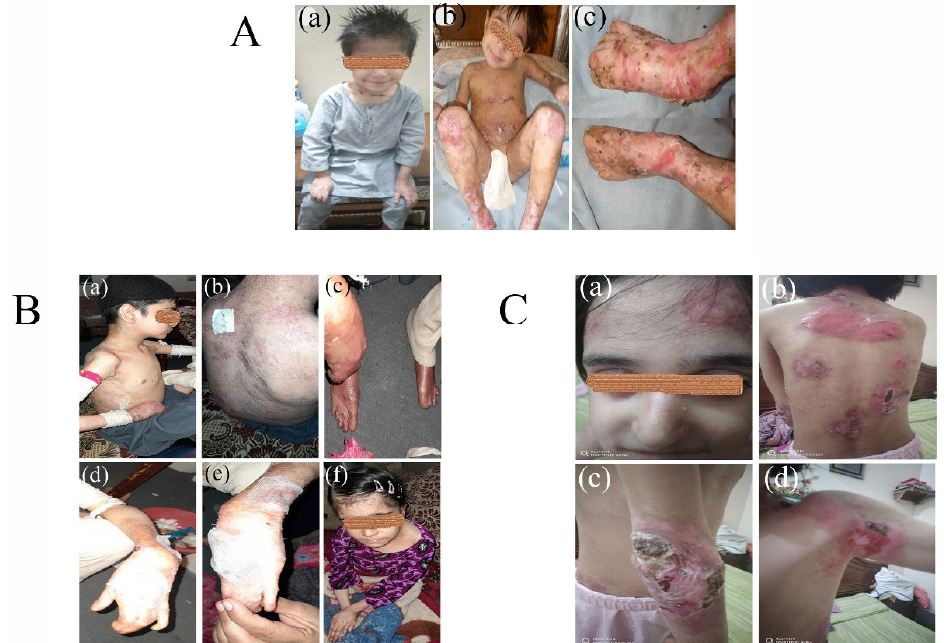
Figure 2. ( A ) Clinical phenotypes of epidermolysis Bullosa in “ Family A ”. Patient V-2 shows classical representation of Recessive Dystrophic EB, generalized severe type with abnormal blistering of the skin, erosions and atypical scarring with erythematous hyperkeratotic papule and keloids affecting his trunk, arms, hands, feet, elbows, knees and genitalia ( Aa – c ), nail dystroph, anonychia ( a ), fusion-induced mitten abnormalities of the hands and toes, joint contractures, pseudo yndactyly and growth delay ( Aa – c ). ( B ) Clinical phenotypes of epidermolysis Bullosa in “ Family B ”. The two affected Patients V-1 and V-4 from “Family B” present cardinal signs of recessive dystrophic EB, generalized severe type with abnormal generalized blistering of the skin and extensive scarring of the whole body ( Ba – f ), with thin and spares scalp hairs ( Bf ), nail dystrophy and onycholysis ( Bc , d ), atrophic scarring, malia ( Ba , b , c , f ), pseudo syndactyly and flexion contracture of joints ( Ba , c , d , e ). ( C ) Clinical phenotypes of epidermolysis Bullosa in “ Family C ”. A 13-year-old girl (V-2) in family C shows typical features of DEB, including abnormal blistering of the skin, erosions and atypical scarring with erythematous hyperkeratotic papule and keloids of skin affecting trunk and extremities ( Cb , c , d ). She has nail dystrophy, joint contractures, severe blistering of oral mucosa and esophageal strictures causing swallowing and feeding difficulties. She also faces severe anemia, growth delay, frequent corneal and conjunctival erosions, symblepharon and, exposure keratitis ( Ca ). The proband (V-1) in Family B demonstrates abnormal generalized blistering of the skin and extensive scarring of the whole body. Opening of the mouth is restricted along with ankyloglossia and feeding difficulties. The limbs show nail dystrophy in form of onychomadesis and onycholysis, atrophic scarring, malia, pseudo syndactyly and restriction of movement due to flexion contracture of joints. Other findings include corneal and conjunctival blistering, anemia, constipation, muscle pains, growth delay, and chronic infections of the respiratory, gastrointestinal, and urogenital systems (Figure 2(Ba–f)). A 13-year-old girl (V-2) in Family C, shows typical features of DEB, including abnormal blistering of the skin, erosions, and atypical scarring with erythematous hyperkeratotic papule and keloids of the skin affecting the trunk and extremities, showing no improvement with advancing age. She has nail dystrophy, along with mitten deformities of phalanges, joint contractures, severe blistering of the oral mucosa and esophageal strictures, causing swallowing and feeding difficulties. She also faces severe anemia, growth delay, frequent corneal and conjunctival erosions, symblepharon, anterior blepharitis, exposure keratitis, and conjunctival complications along with other organ system infections (Figure